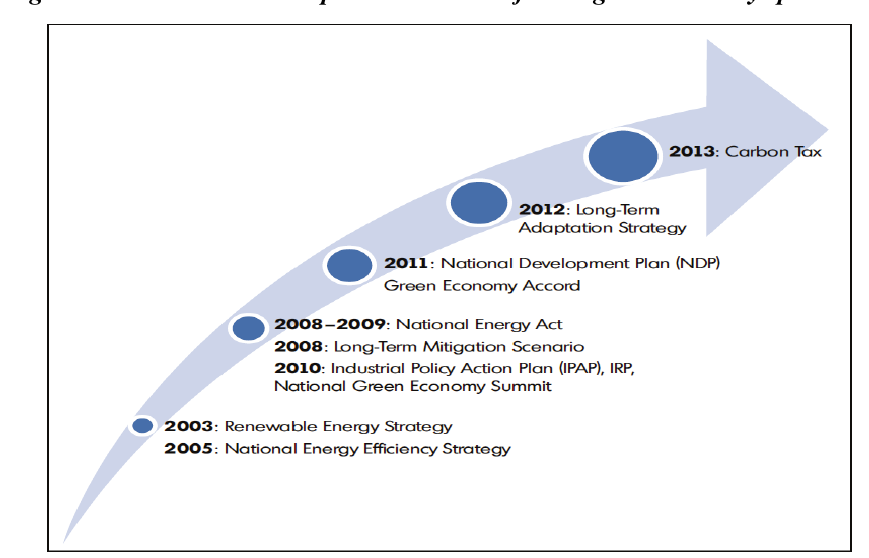
Figure 10: Landmark development in South Africa’s green economy space